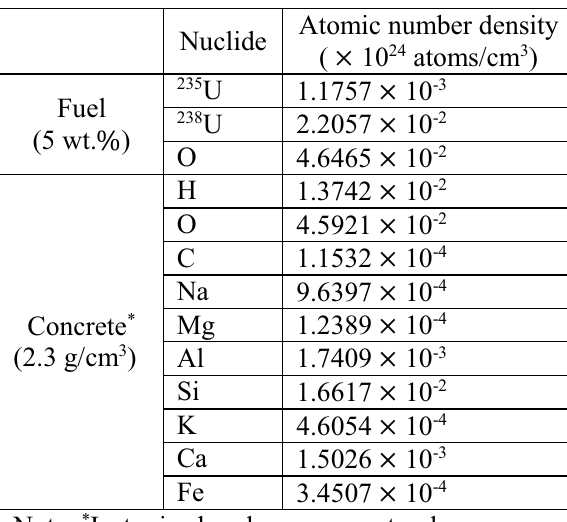
Table I. Compositions of Fuel and Concrete.